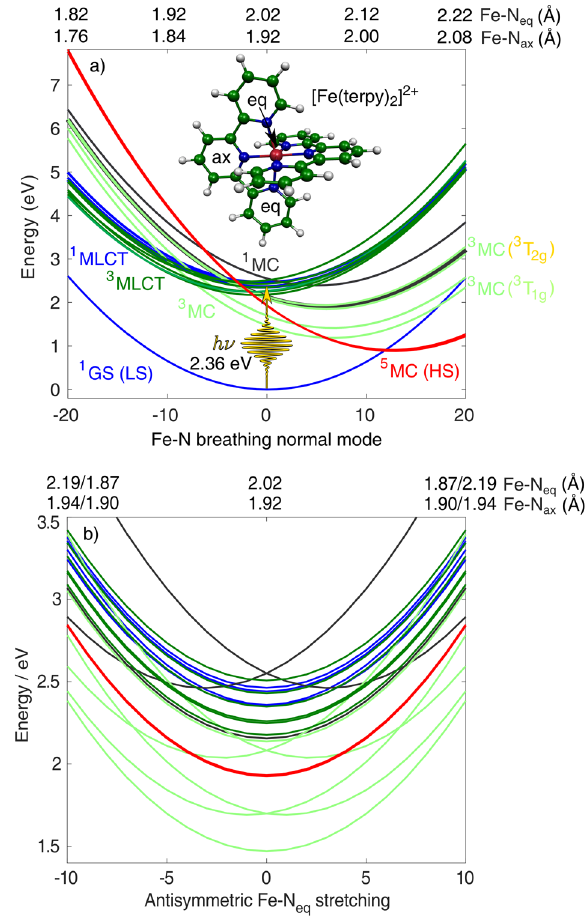
Fig. 1 Diabatic potentials of [Fe(terpy) 2 ] 2 + along two normal modes. The two panels show the potential energy surfaces along the a Fe-N breathing and b antisymmetric Fe-N eq stretching normal modes. The utilised normal mode coordinates are dimensionless (mass-frequency-scaled normal mode coordinates). Also shown is the molecular structure of the [Fe(terpy) 2 ] 2 + complex with “ ax" and “ eq" denoting the axial and equatorial nitrogen positions, respectively, as well as the 1 GS → 1 MLCT excitation process ( Δ E = 2.36